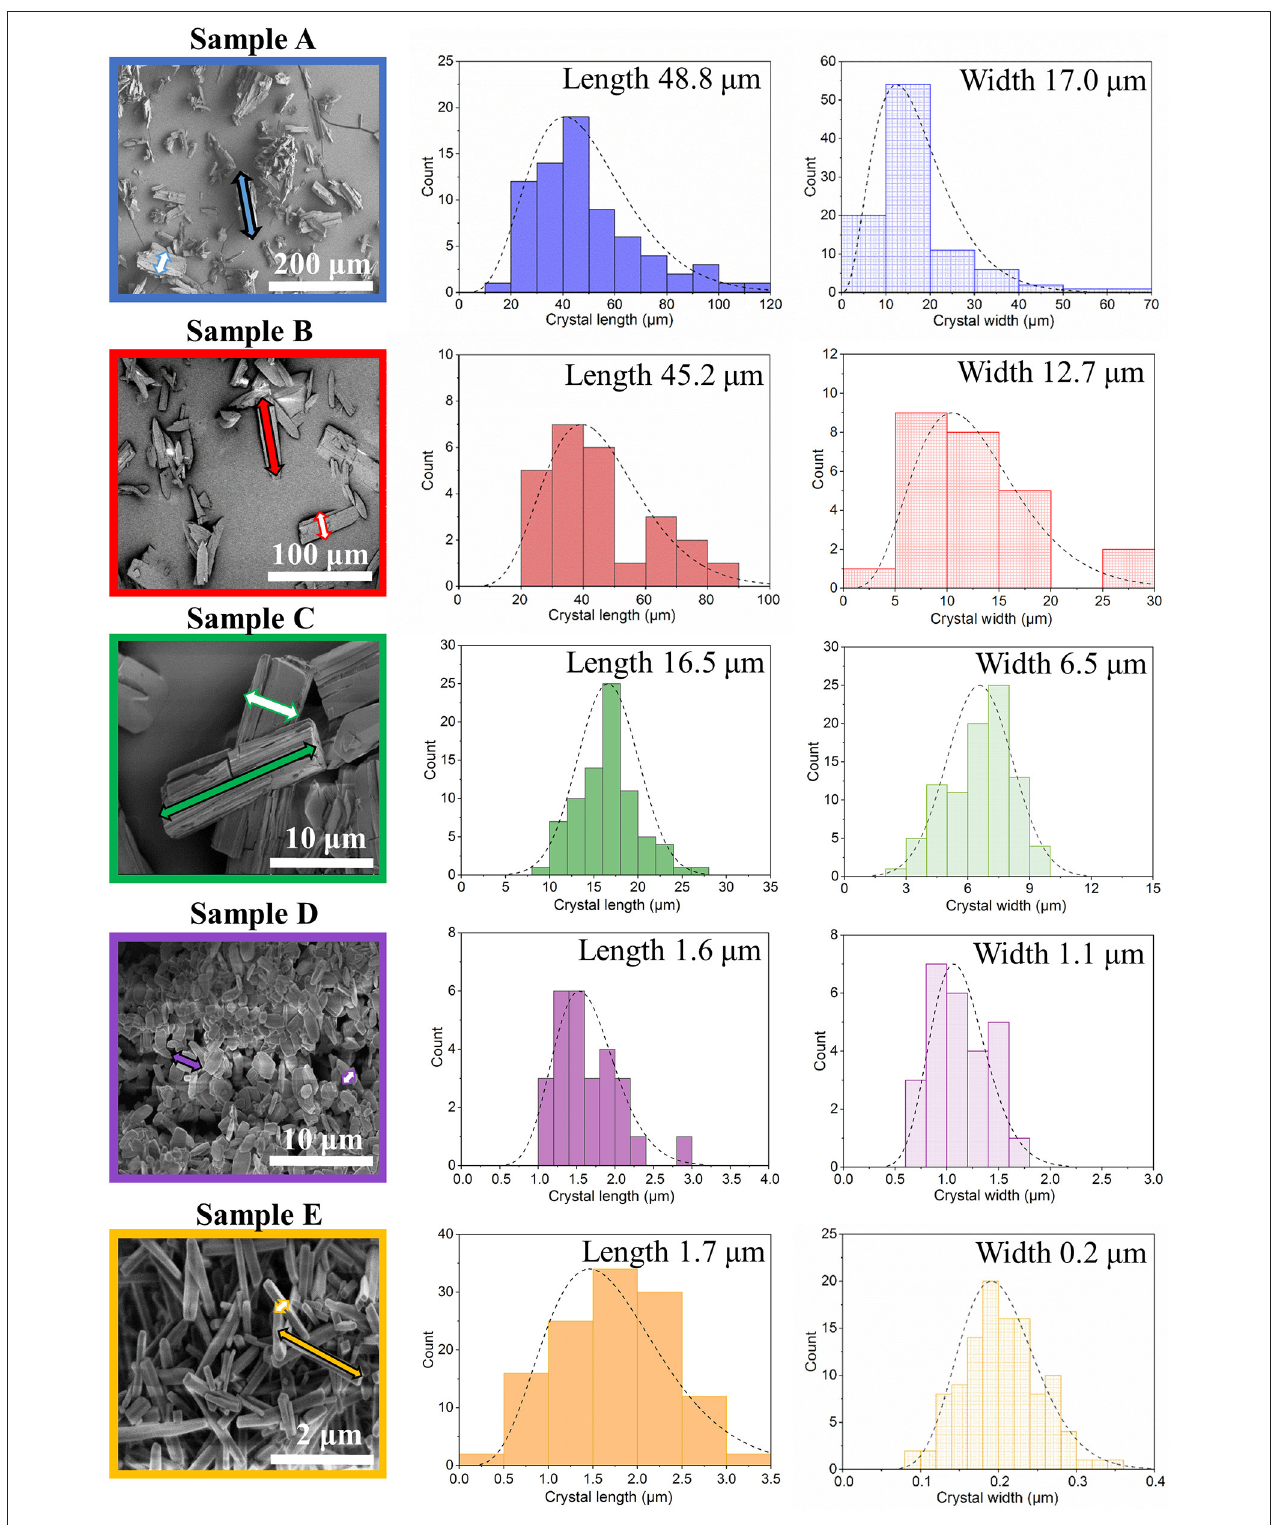
FIGURE 2 | SEM images and particle size distributions (length marked as a filled arrow in SEM and width marked as an empty arrow in SEM) of the investigated samples.